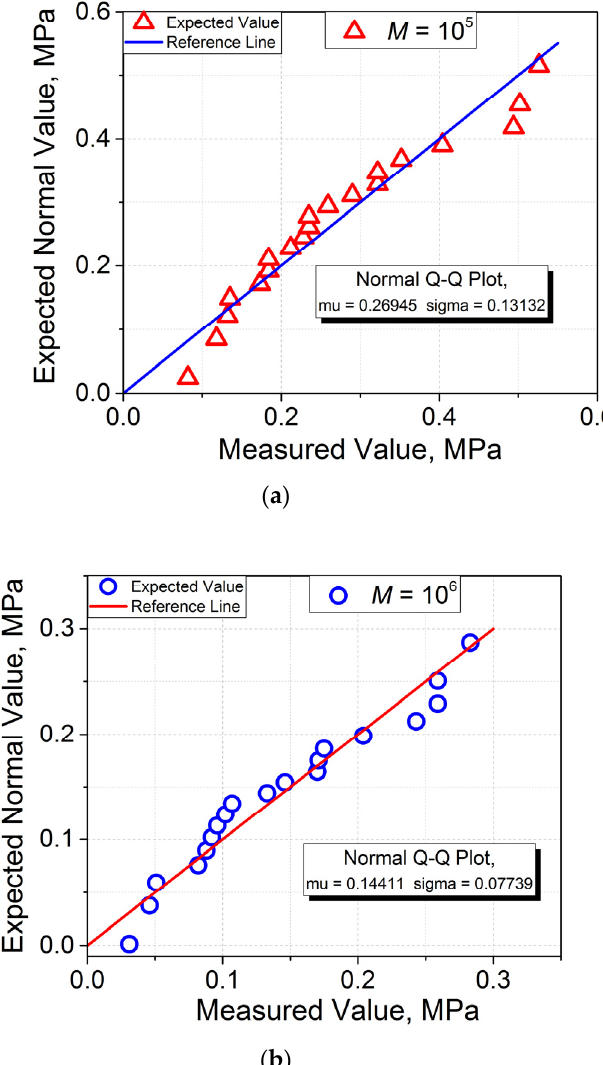
Figure 4. Quantile–quantile plots for ( a ) AJ PS1–PS1 and ( b ) AJ PS2–PS2. Table 2. Statistical parameters of the lap-shear strength distribution for two PS–PS interfaces estimated from the Chen–Shapiro normality Table 1. Statistical parameters of the lap-shear strength distribution estimated for two PS–PS in- terfaces in five normality tests.